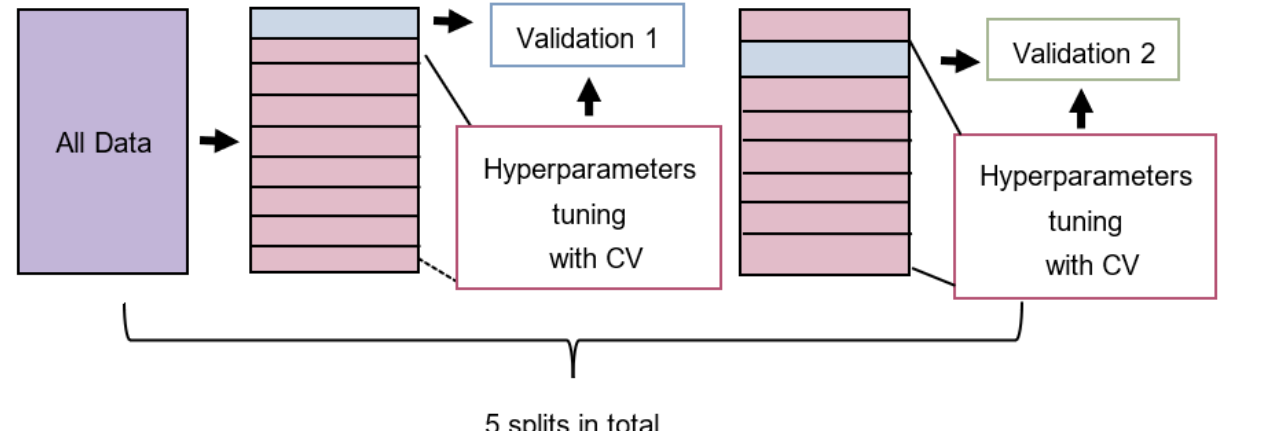
Figure 1. Graphical representation of the model training process. Data was split five times into different test and training sets. The training set was then used for tuning the hyperparameters using 5-fold cross-validation (CV) while the test set was used to evaluate the trained models.